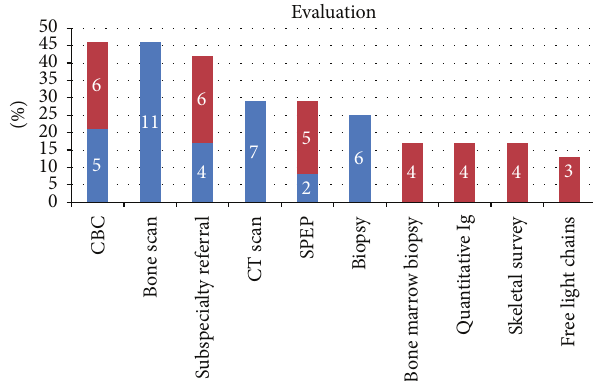
Figure 3: Percentage of evaluated patients ( 𝑁 = 110) undergoing each test. Red bars indicate hematology/oncology referral and subsequent testing by hematology/oncology. Numbers on the bars are the actual numbers of patients evaluated with each